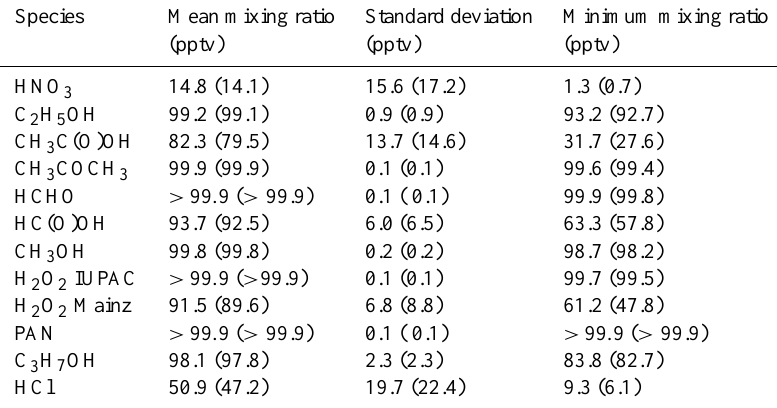
Table 2. Mean, standard deviation and minimum gas phase mixing ratio on the time interval when dry ice is present over the seven trajectories computed in the REF simulation. The total mixing ratio for all species is assumed to be 100pptv. The results of the RUN1M simulation are given in